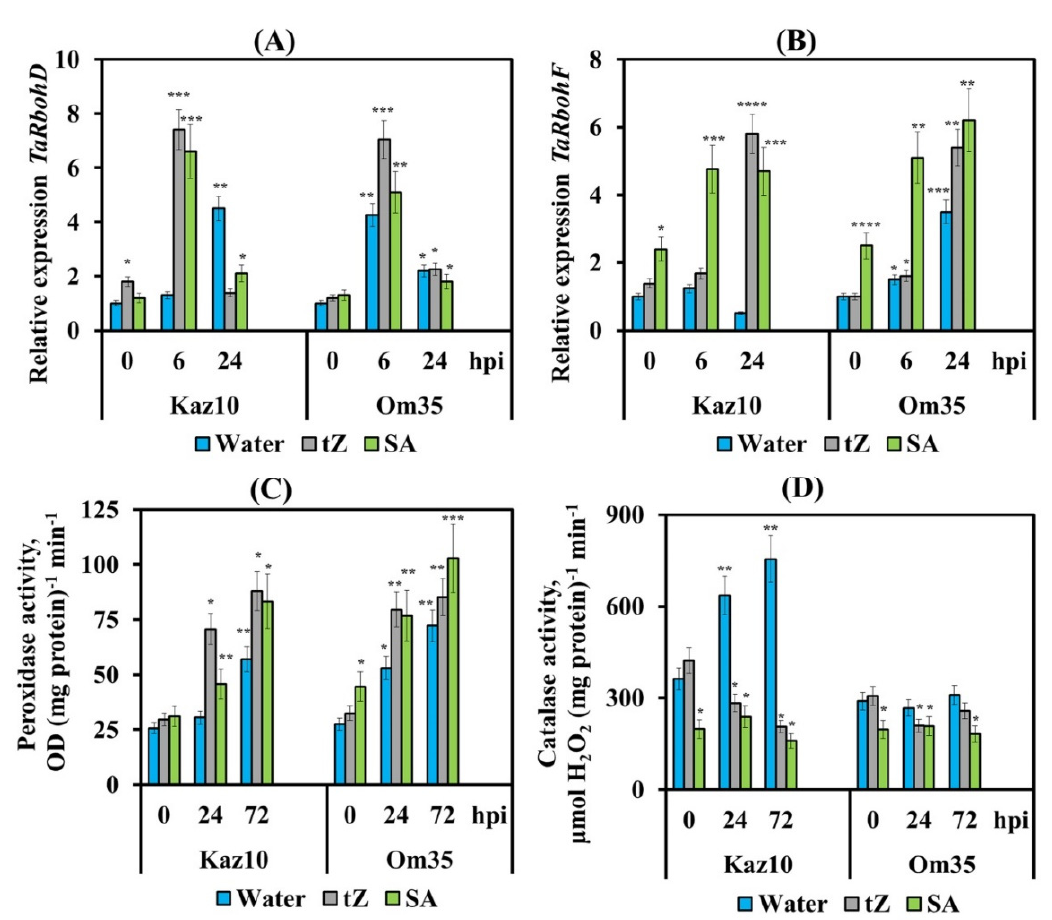
Figure 6. The effect of pretreatment with tZ and SA on the relative expression of genes encoding NADPH oxidase, and activity of peroxidase and catalase in two wheat cultivars of in Kaz10 and Om35 infected with SnB. ( A ) The mRNA abundance of the TaRbohD gene in the Kaz10 and Om35 at 6 and 24 hpi. ( B ) The mRNA abundance of the TaRbohF gene in the two Kaz10 and Om35 cultivars at 6 and 24 hpi. Expression values were normalized to the housekeeping gene TaRLI as an internal reference and expressed relative to the normalized expression levels in mock-treated control (water) plants at 0 hpi. ( C ) Peroxidase activity in the Kaz10 and Om35 cultivars at 24 and 72 hpi. ( D ) Catalase activity in the Kaz10 and Om35 cultivars at 24 and 72 hpi. Symbols are the same as in Figure 5. Figures present means ± SE (n = 6). Asterisks indicate means statistically different from the control and different number of asterisks (*, **, ***, ****) allows distinguishing of significantly different variants according to the LSD test at * p < 0.05, ** p < 0.01, *** p < 0.001, **** p < 0.0001.